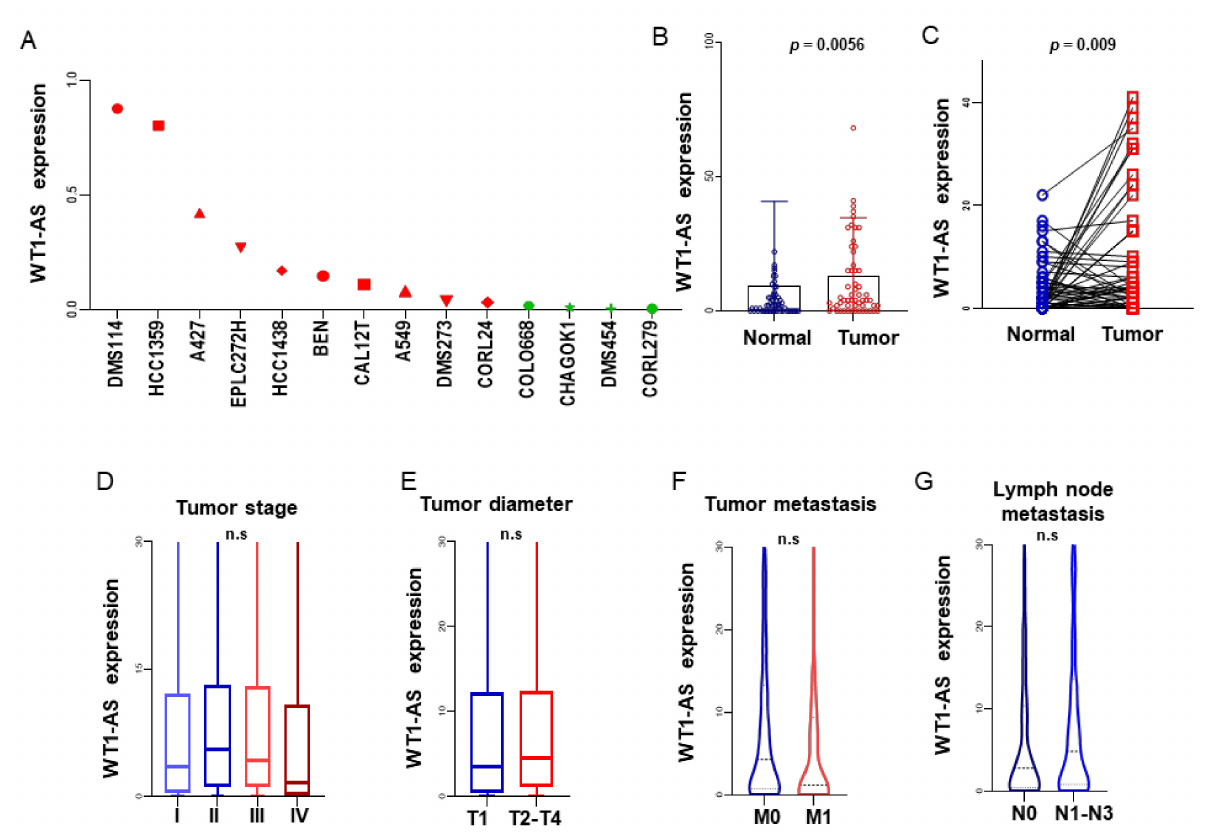
Figure 3. The expression levels of WT1-AS in different lung cancer cell lines were downloaded from CCLE ( A ). The expression level of WT1-AS in tumor tissues and adjacent tissues of LUAD patients was significantly different ( B ). Paired difference analysis ( C ). The relationship between WT1-AS and LUAD stage, tumor diameter, tumor metastasis, and lymph node metastasis ( D – G